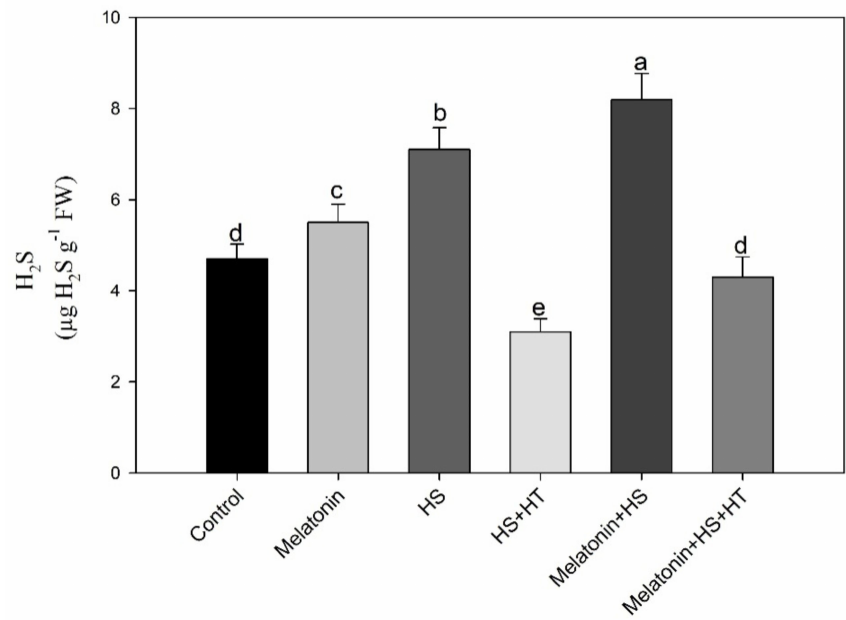
Figure 6. Content of H 2 S in wheat ( Triticum aestivum L. var. WH 542) leaves at 30 days after sowing (DAS). Plants were treated with melatonin (100 µ M) and/or HT (100 µ M) in the presence (40 ◦ C) or absence (25 ◦ C) of heat stress. Data are presented as means ± SE ( n = 4). Data followed by the same letter are not significantly different by LSD test at p < 0.05. HS, heat stress; HT;